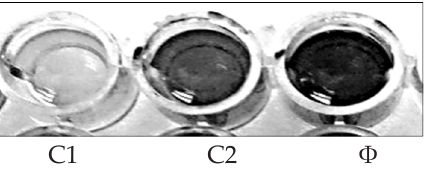
Figure 3. Microtiter plate biofilm alone (Ø), and biofilm inhibition of S aureus (C1) and B. subtilis (C2) .